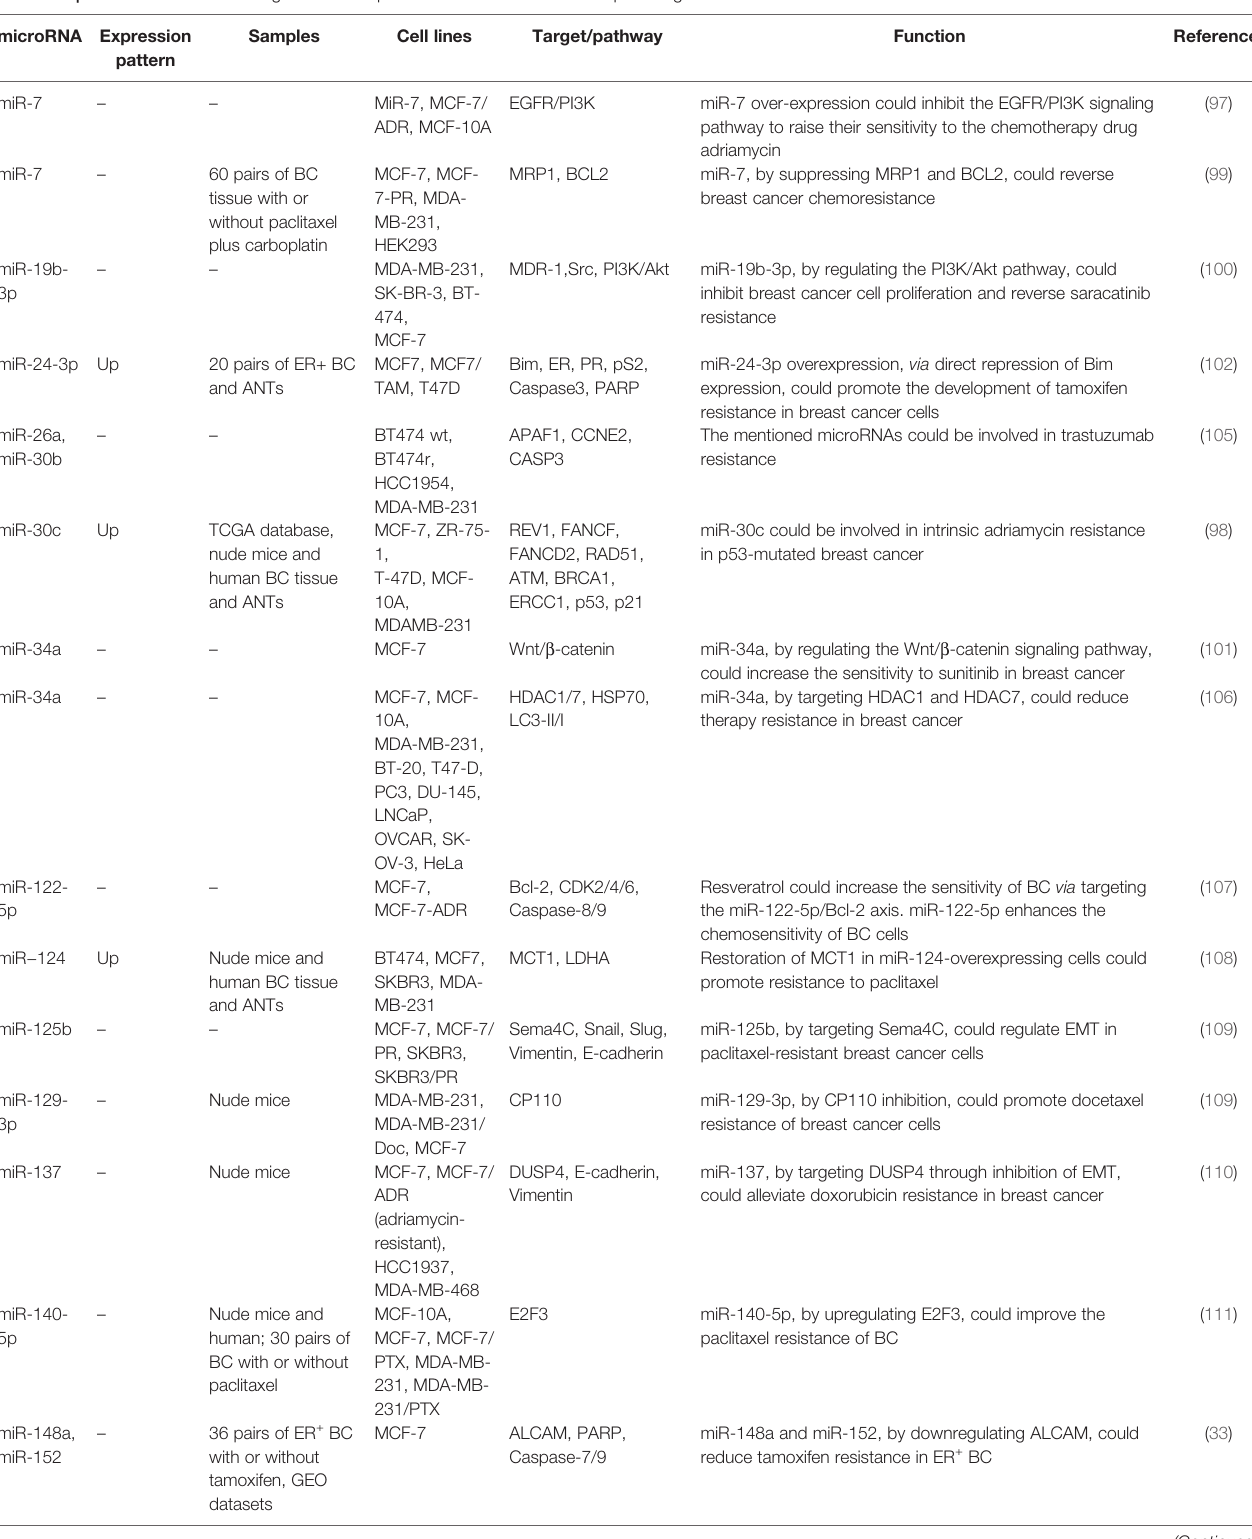
TABLE 4 | Role of miRNAs in the regulation of response of breast cancer to therapeutic